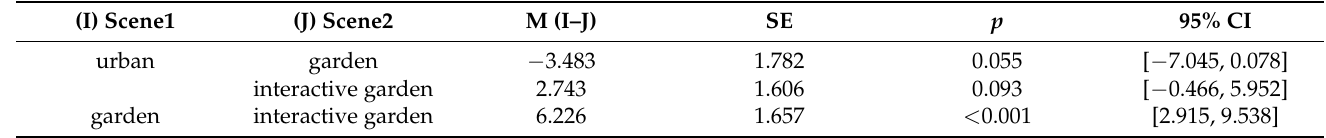
Table A4. Paired comparison results of the change of CRAT.